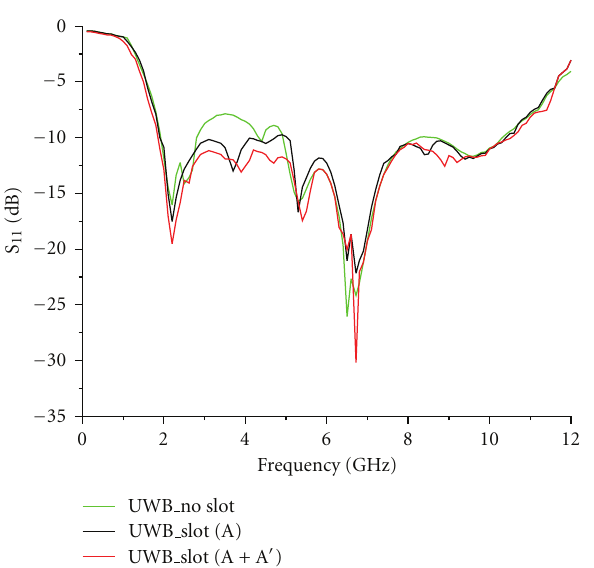
Figure 7: Measured results of S 11 of the proposed antenna.